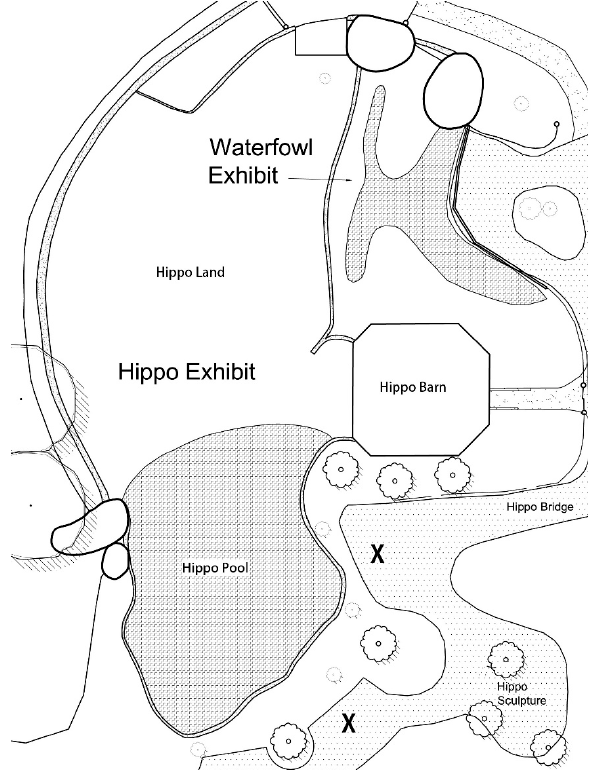
Figure 1. Hippo exhibit, with the two observational areas a hippo could be during the study (hippo pool and hippo land), observation points for all behavioral observations (marked ‘X’), and the indoor hippo barn (night enclosure) and surrounding